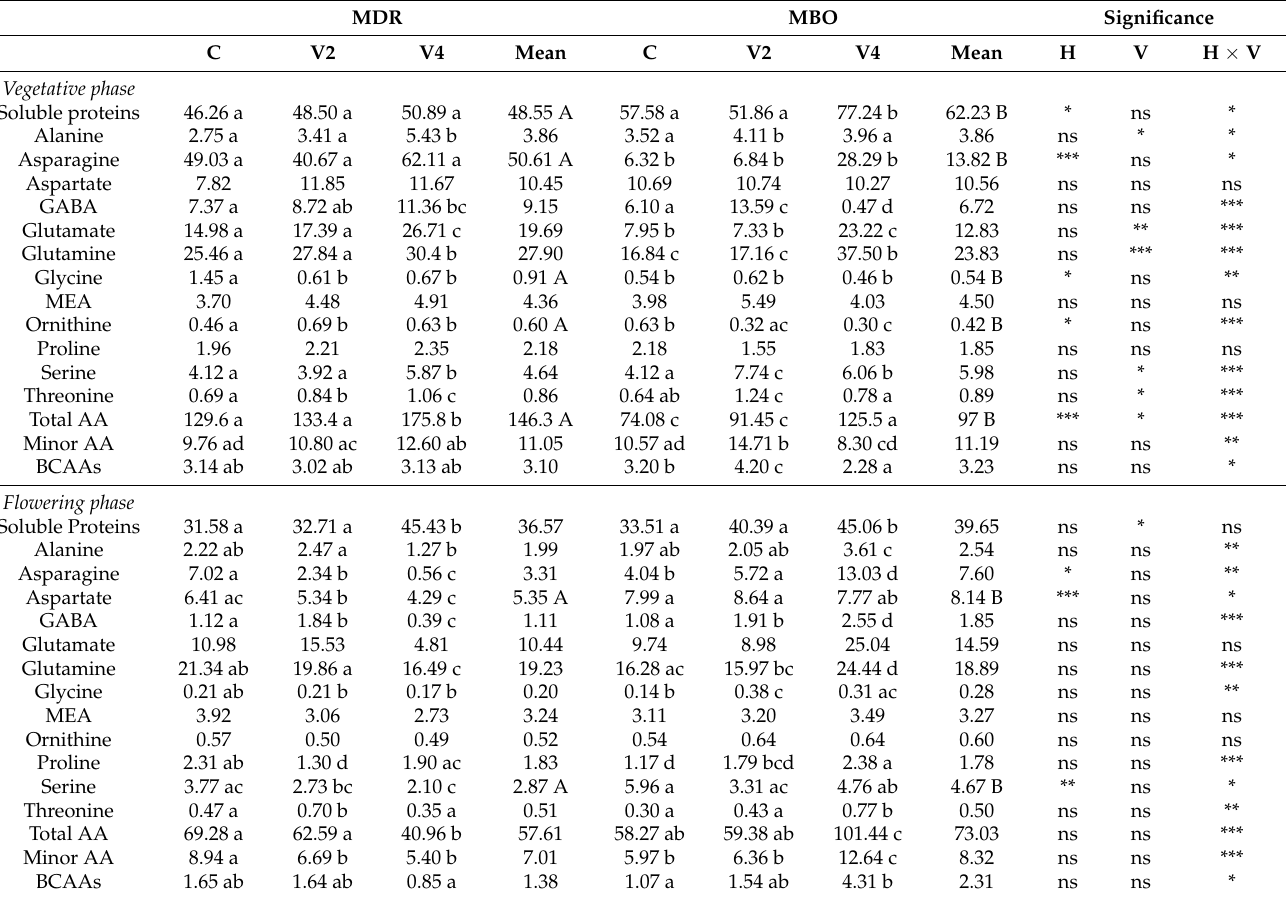
Table 4. Soluble proteins (in mg g − 1 DW) and free amino acids (in µ mol g − 1 DW) in plants of Ranunculus asiaticus L. hybrids MDR and MBO, obtained by three vernalization procedures of tuberous roots, only rehydration (Control, C), rehydration plus vernalization for 2 weeks (V2), rehydration plus vernalization for 4 weeks (V4). Week 8 from planting (vegetative phase). Amino acids (AA), γ -aminobutyric acid (GABA), monoethanolamine (MEA), branched-chain amino acids (BCAAs). ns, *, ** and ***; indicate non-significant or significant difference at p ≤ 0.05, p ≤ 0.01, p ≤ 0.001, respectively. Different lowercase or capital letters within each row, for specific vernalization procedure, indicate significant differences ( p ≤ 0.05). MDR MBO